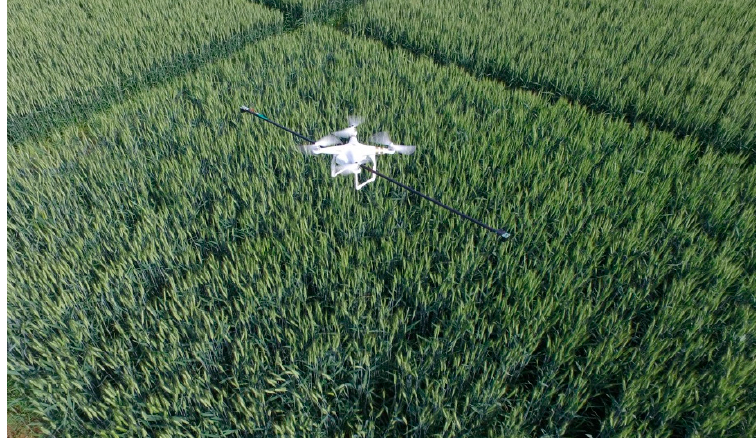
Figure 12. Field tests based on UAV-borne crop-growth monitoring system.